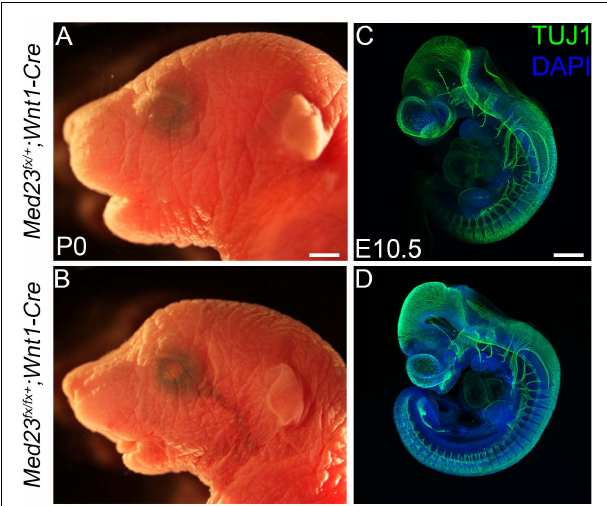
FIGURE 7 | Conditional deletion of Med23 in neural crest cells. (A,B) Brightfield images of P0 Med23 fx / + ;Wnt1-Cre and Med23 fx / fx ;Wnt1-Cre embryos indicate that the mutants exhibit micrognathia. (C,D) TuJ1 staining of E10.5 Med23 fx / + ;Wnt1-Cre and Med23 fx / fx ;Wnt1-Cre embryos however revealed proper formation of the cranial ganglia in mutant embryos. Scale bars for (A,B) is 450 um, (C,D) is 375 um. gross craniofacial, or vascular defects at E10.5 ( Figures 8C,D ).